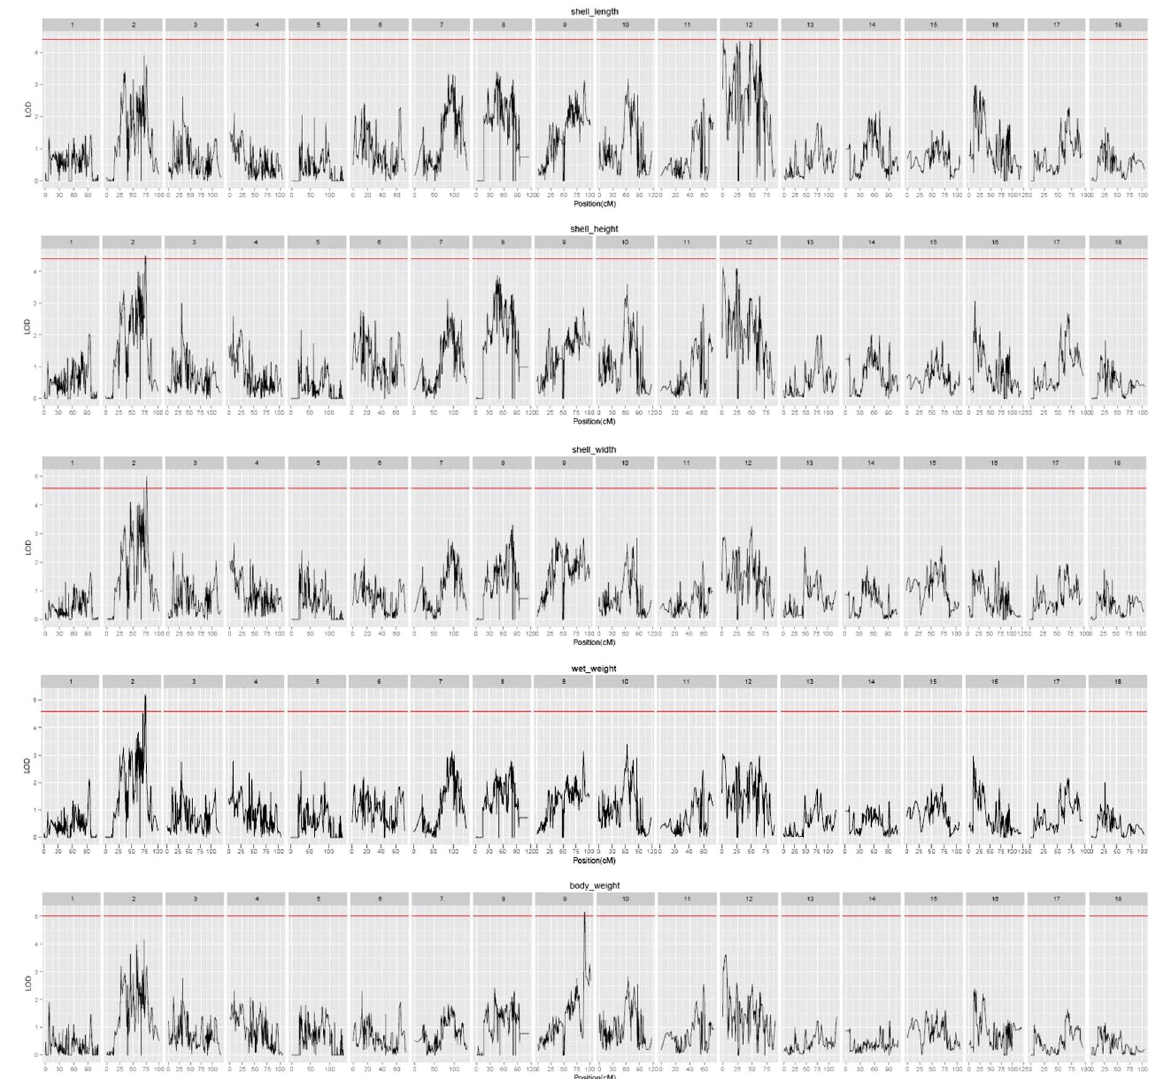
Figure 3. Growth-related QTL mapping and association analysis in R. philippinarum among all linkage groups.